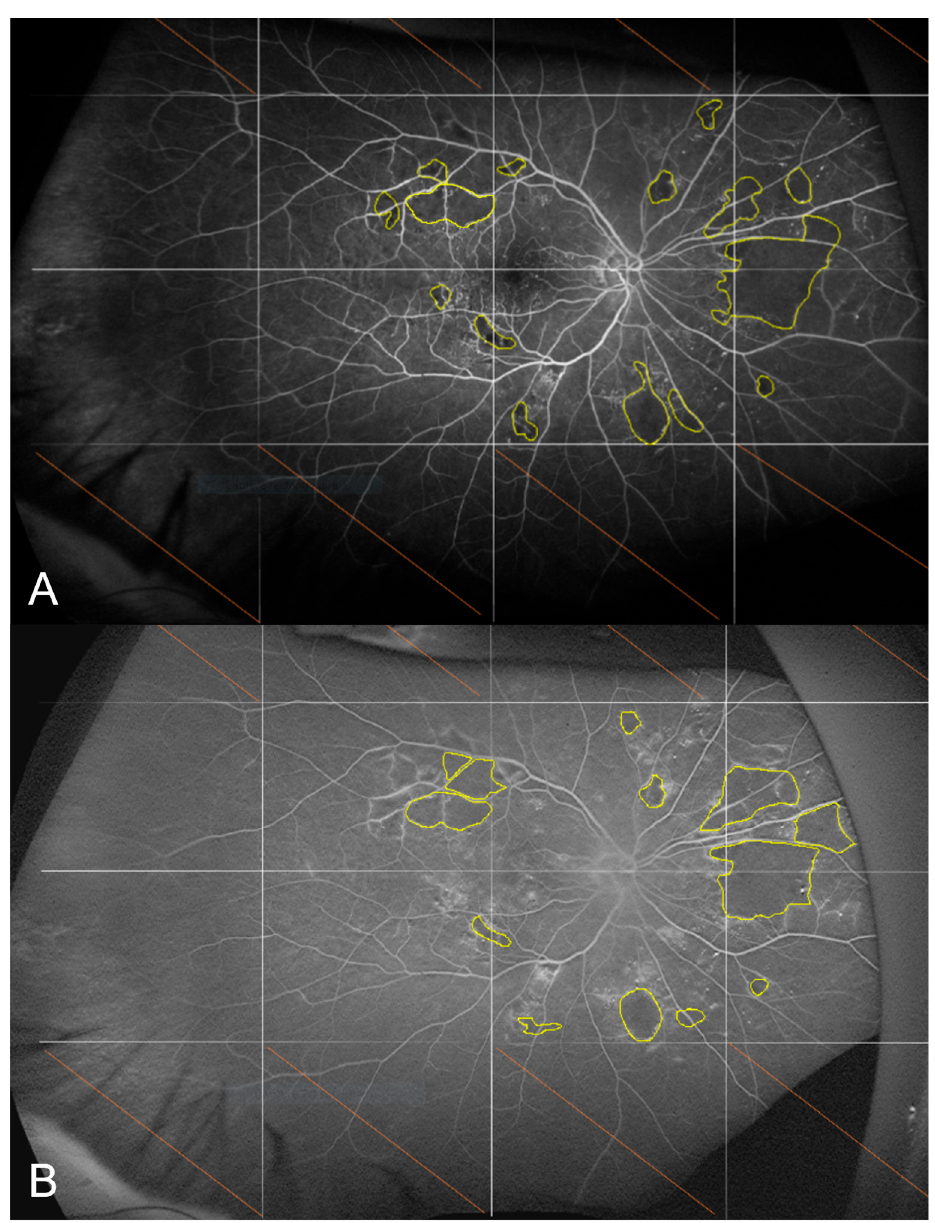
Figure 4. Fluorescein angiograms of the right eye acquired 45 sec after dye injection at baseline ( A ) and at M12 ( B ). The non-perfusion index was 0.6% at M0 and 0.7% at M12 for this patient.